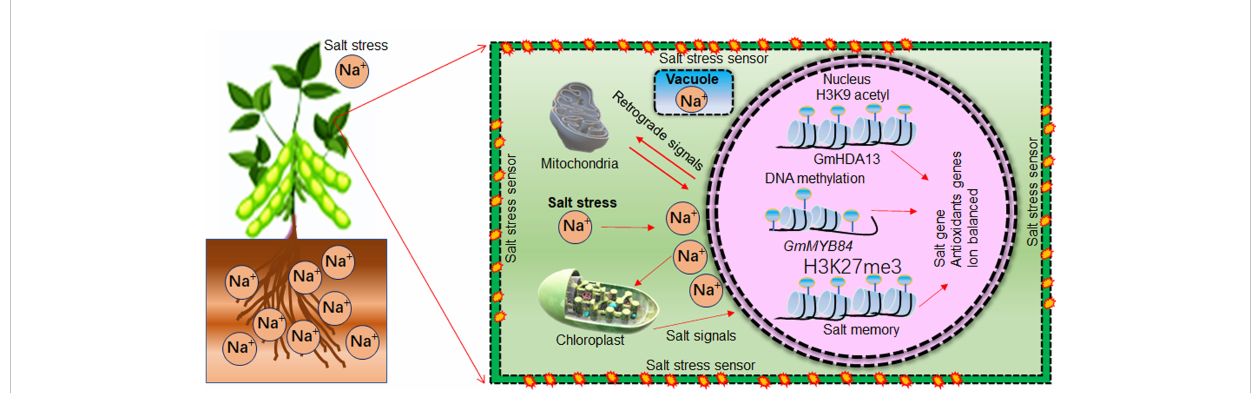
FIGURE 9 Role of epigenetics and retrograde signaling in Soybean salt tolerance Epigenetic modi fi cation alters the transcriptional landscape of salt stress responsive genes through methylation and acetylation. These changes are also a source of epigenetic memory that help to survive the plants under repertoire stresses. Retrograde signaling between different organs like chloroplast and nucleus helps salt homeostasis and activation of different stress-responsive pathways to reduce the salt effects in